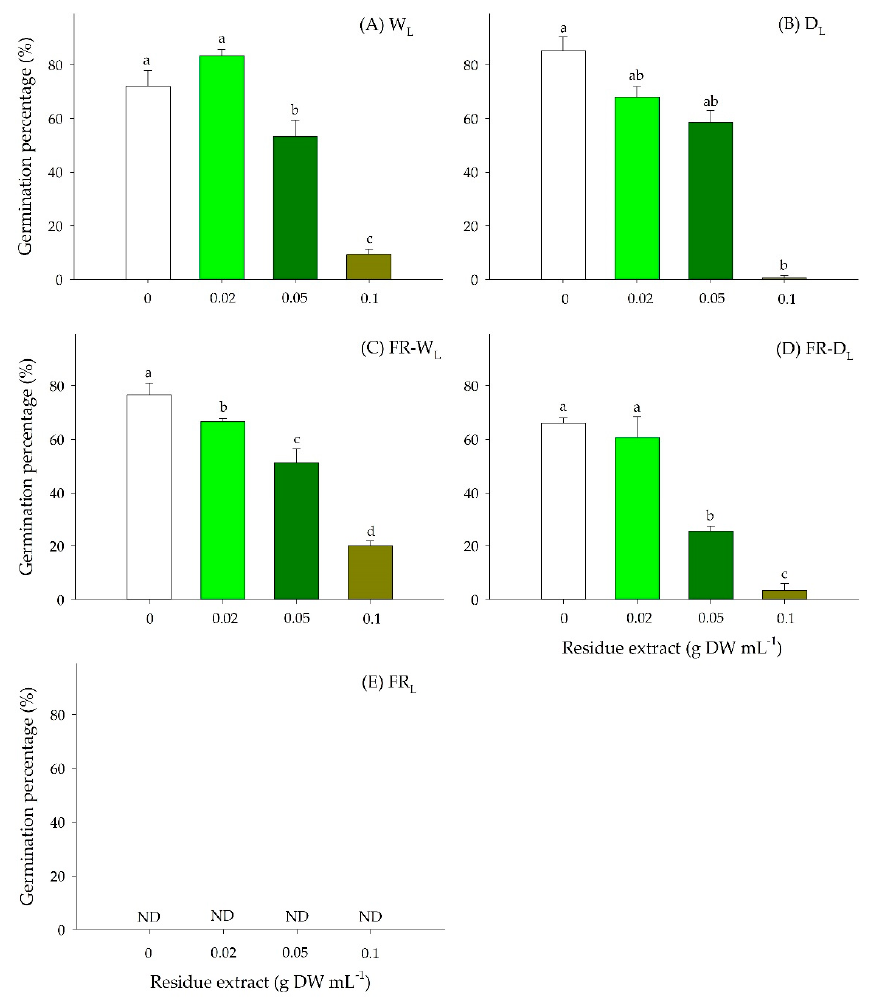
Figure 2. Seed germination percentage (%) of Bidens pilosa L. (Cobbler’s pegs) in four concentrations of residue extract (0, 0.02, 0.05 or 0.1 g dry weight (DW) mL − 1 ) and under five di ff erent light treatments in the laboratory experiment. Light treatments were ( A ) incubated in the white light with a 12-h (h) photoperiod (W L ); ( B ) incubated in the continuous darkness by wrapped with two layers of aluminum foil (D L ); ( C ) pretreated in the far-red light (FR) for 3 h then incubated in the white light with a 12-h photoperiod (FR-W L ); ( D ) pretreated in the FR for 3 h then incubated in the continuous darkness (FR-D L ); ( E ) incubated in FR with a 12-h photoperiod (FR L ). The light intensities of white light (LED, 400–750 nm, 6500 k) and FR (LED, 730 nm) were 149 µ mol m − 2 s − 1 and 0.71 µ mol m − 2 s − 1 , respectively. The red / far-red ratios (R / FR) of white and far-red LED light were 11 and 0.01, respectively. Error bars are the standard error ( n = 5). The same letters in ( A , C , D ) indicate no significant di ff erence at p < 0.05 by Fisher’s protected LSD test, while in ( B ) indicate no significant di ff erence at p < 0.05 by Dunn’s post hoc comparison test. ND in ( E ) means no seed germinated in FR L treatment during the 5-day